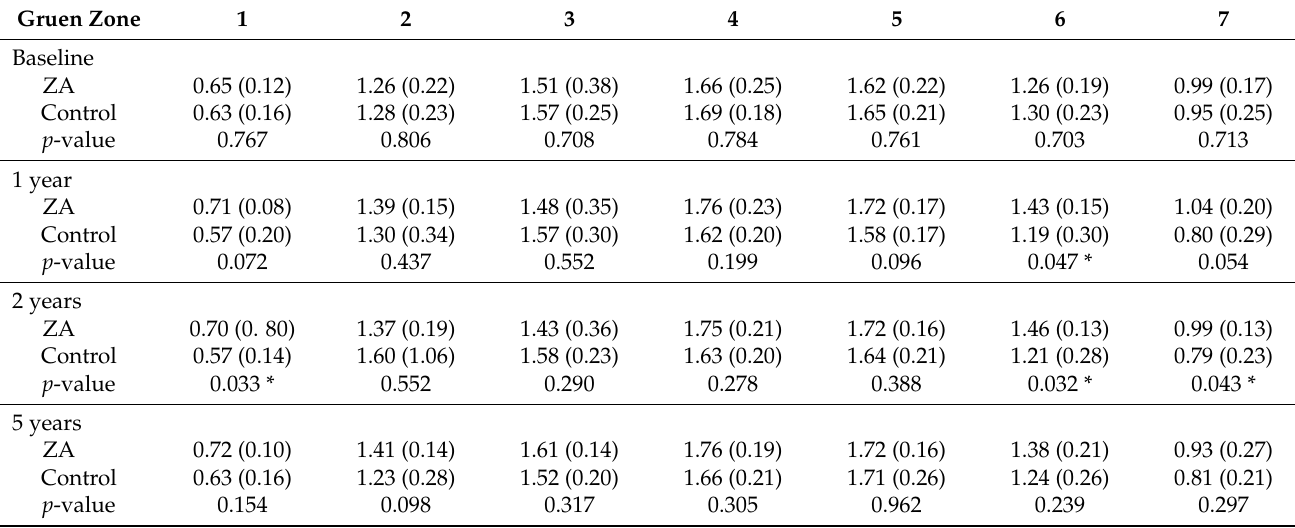
Table 3. Mean BMD (g/cm 2 ) for ZA ( n = 9) and control ( n = 10) by Gruen zones.